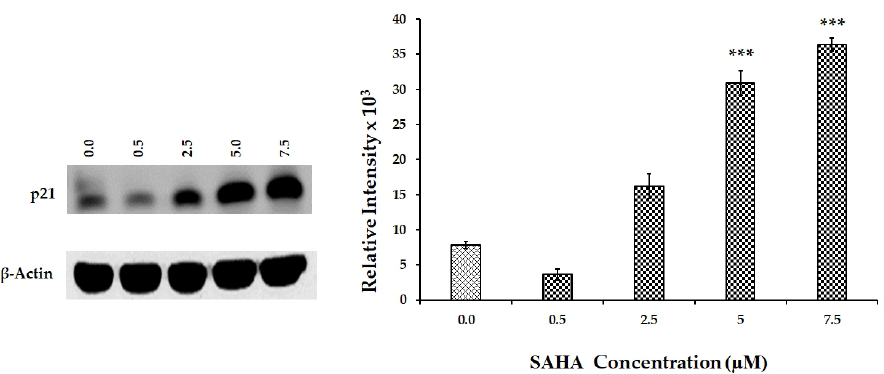
Figure 5. Dose dependent response of p21 expression in SAHA (0.5–7.5 µ M) treated MCF-7 cells. The level of significance is indicated as *** p < 0.001 compared to control.